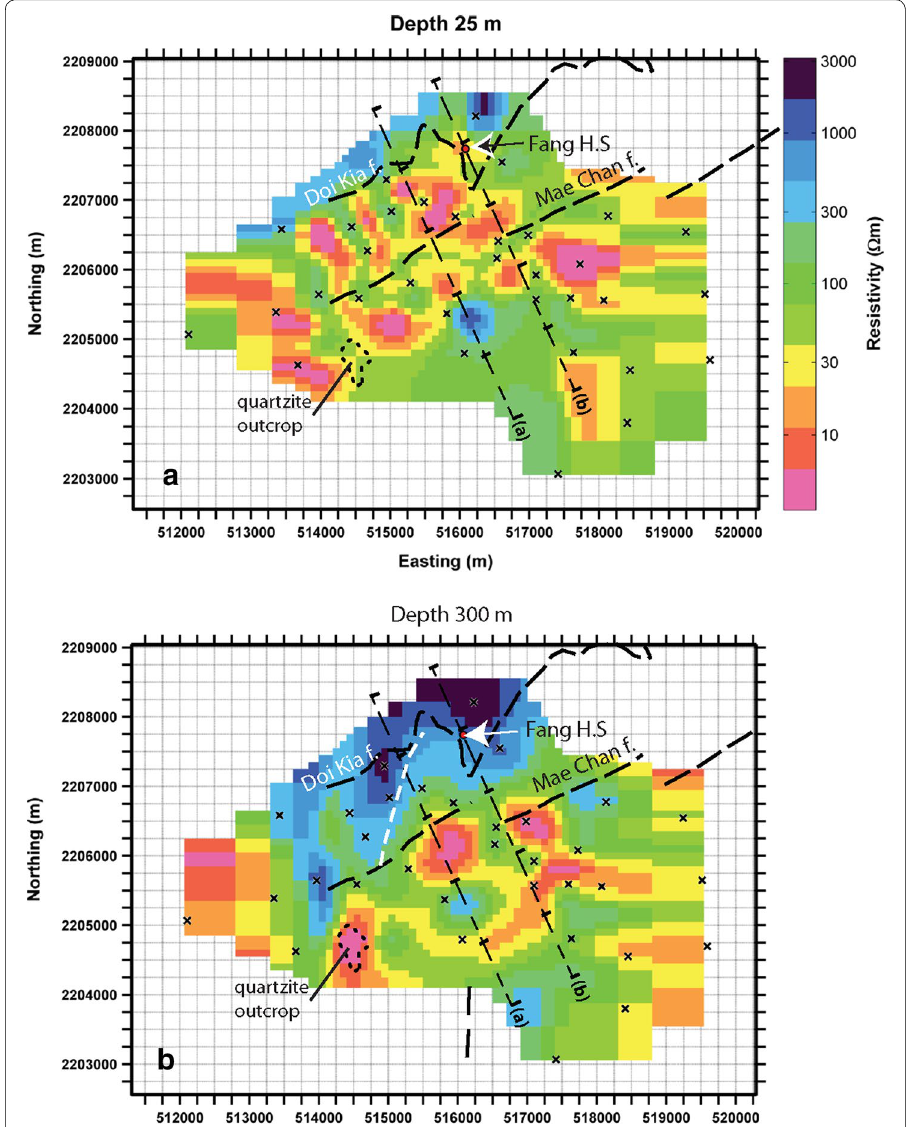
Fig. 21 Map view slices at 25 m and 300 m depths of the final inverted 3D-Magnetotelluric resistivity survey of Amatyakul et al. (2016). These slices are from an earlier report on that data by Siripunvaraporn (2015). Traces of faults from geologic mapping of Fig. 9 are dashed black lines. Map a (25 m depth) shows the small area of the shallow, low resistivity (< 30 Ωm, colored orange) anomaly at Fang Hot Springs. Deeper slices show only high resistivity beneath the geothermal area. The map shows low resistivity (colored orange) which is associated with the Paleozoic sedimentary rock overlying the crystalline rock (> 300 Ωm, colored blue) between the Doi Kia fault and the Mae Chan fault. Low resistivity rock south of the Mae Chan fault is the shaly Cenozoic basin fill. Map b (300 m) shows the crystalline rock is beneath the hot springs, and low resistivity Cenozoic basin fill southeast of the Mae Chan fault. The white line shows N–NE trending boundary between crystalline rock to the west and sedimentary rock to the east. This feature is not evident in geologic mapping, and appears only on slices deeper than 200 m. The boundary shows up clearly in cross section on the vertical slice, where it appears to dip 55°SE (Fig. 22a). The structure suggests uplifted crystalline rock to the west and may account for the isolated Paleozoic quartzite outcrop in the basin shown in the